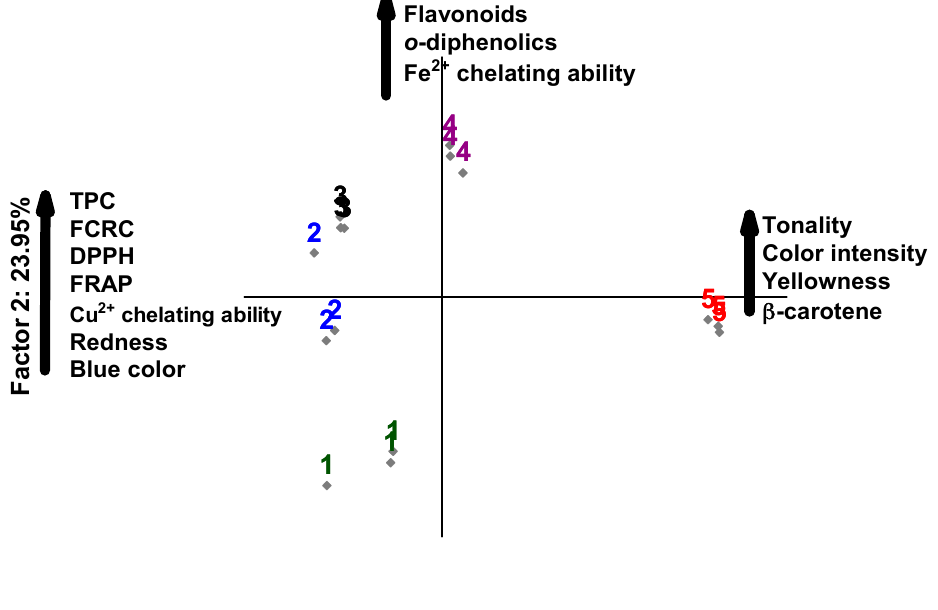
Figure 1. Principal component analysis based on physicochemical properties and antioxidant activity of marigold flower extracts ( Calendula officinalis L.). Extract 1 = 100% H 2 O:0% EtOH; extract 2 = 75% H 2 O:25% EtOH; extract 3 = 50% H 2 O:50% EtOH; extract 4 = 25% H 2 O:75% EtOH; and extract 5 = 0% H 2 O:100% EtOH. TPC = total phenolic content; FCRC = Folin–Ciocalteau reducing capacity.